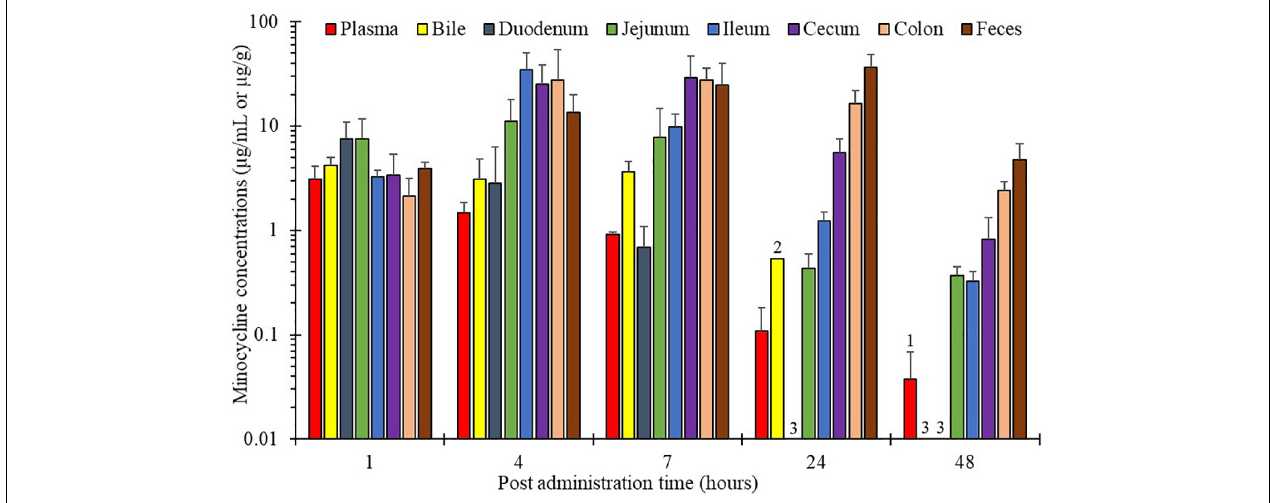
FIGURE 1 | Minocycline concentrations (mean ± SD) over time in plasma and in different intestinal matrices of piglets after a single intravenous administration of 8 mg/kg minocycline ( n = 3). (1) One datum below the LOQ. (2) Two data below the LOQ. (3) Three data below the LOQ. LOQ plasma = 0.05 µ g/mL, LOD intestinalmatrices = 0.25 µ g/mL or µ g/g.